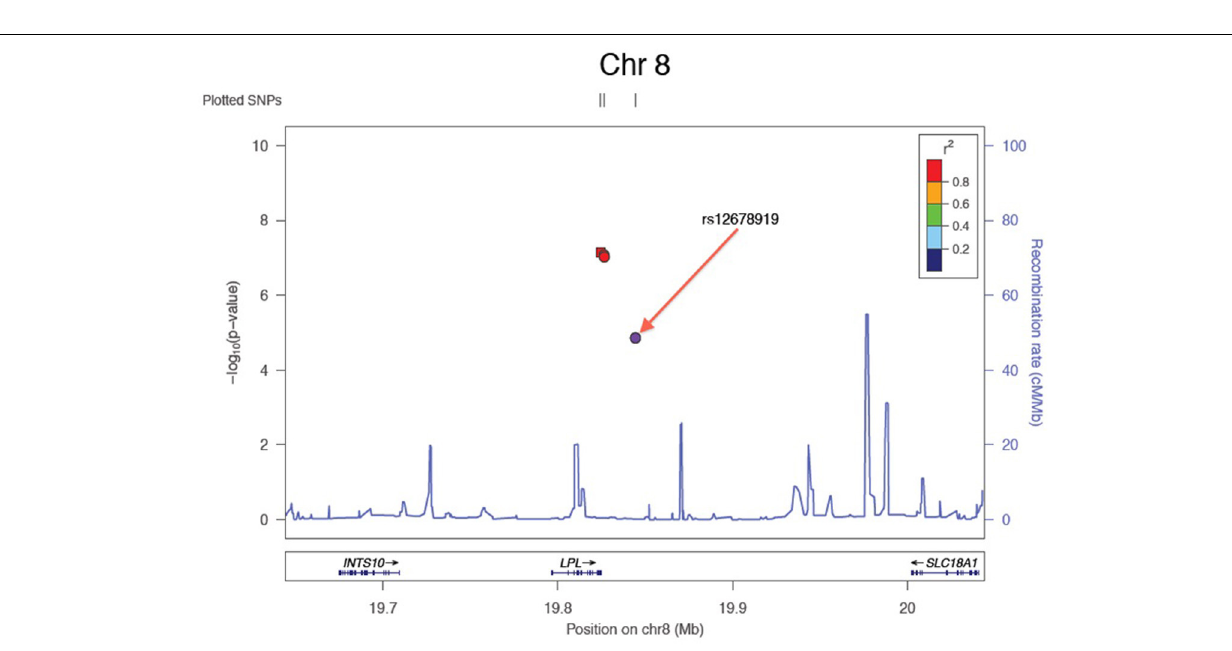
level of statistical significance. The well-documented asso- ciation of LDL-C levels with APOE on chromosome 19 (Waterworth et al., 2010), was also detected, with a p -value of 1.56 × 10 − 12 .